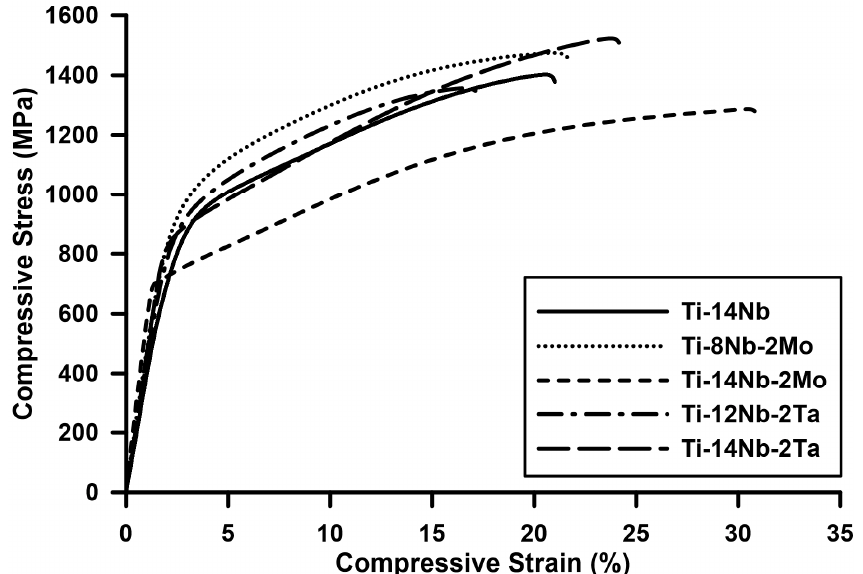
Figure 6. Compression stress–strain curves of the investigated materials. Table 1. Mechanical properties of the investigated